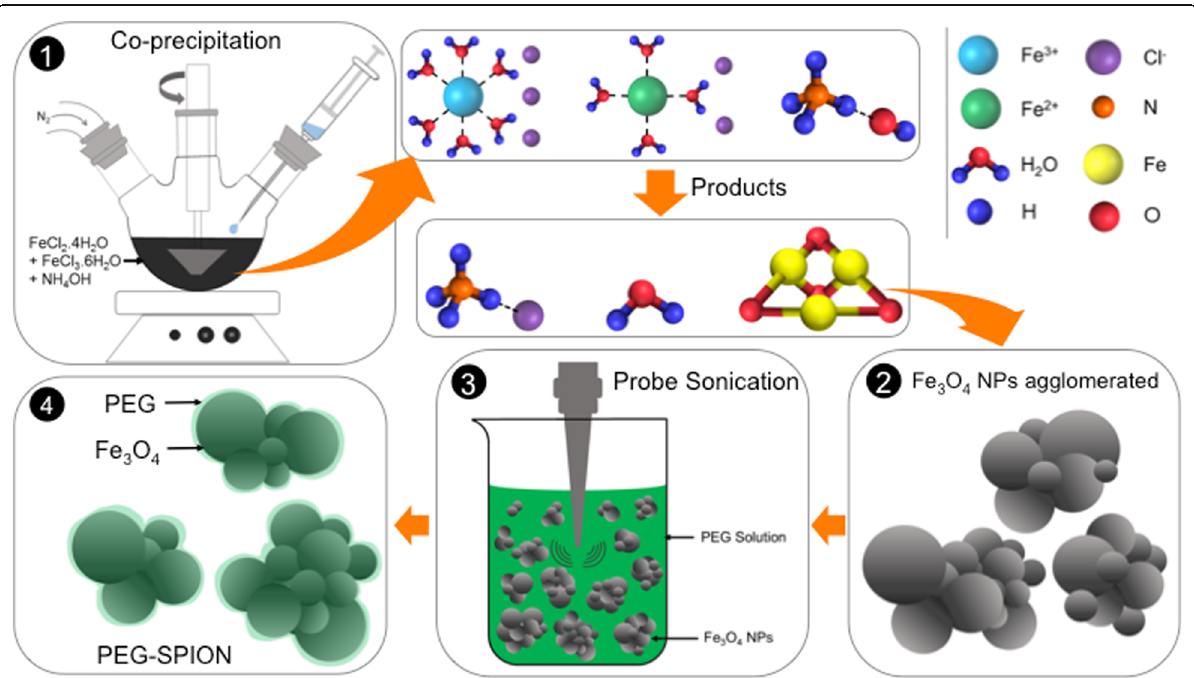
Fig. 4 Schematic representation of the growth mechanism of PEG-SPION, which can be visualized as a core-shell system consisting of a superparamagnetic core and a magnetically disordered shell